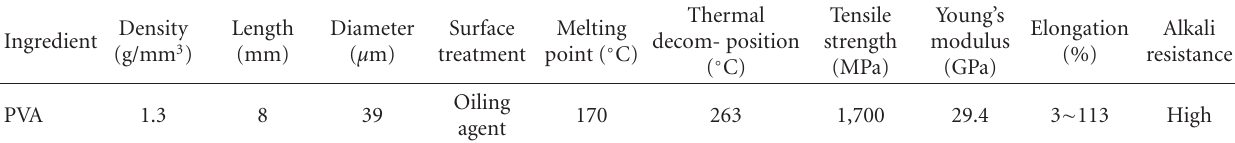
Table 2: Properties of fibers.